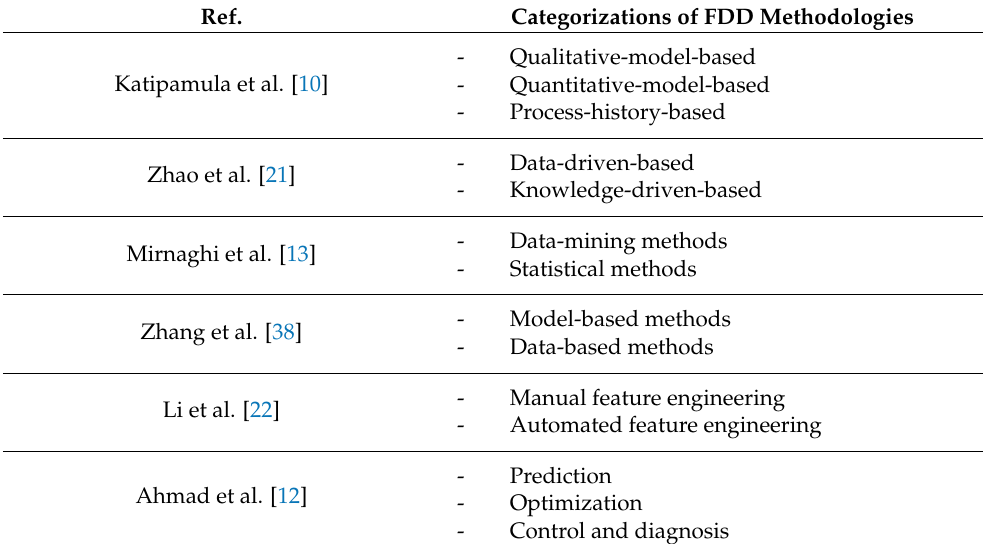
Table 4. Categorization of methods in selected articles used to streamline the categorizations found in the explored literature. The mentioned references below created categorizations in their review.